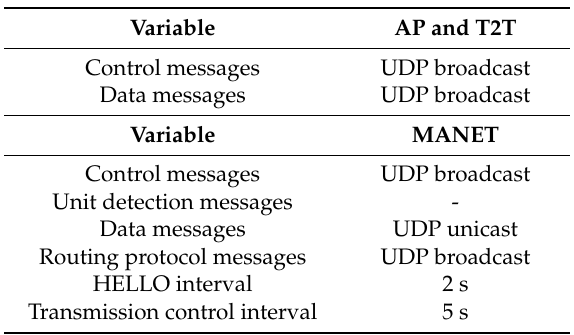
Table 4. Message setup for AP, T2T and MANET